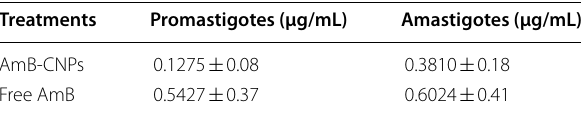
Table 3 Mean IC50 values of amphotericin B-loaded chitosan nanoparticles (AmB-CNPs)